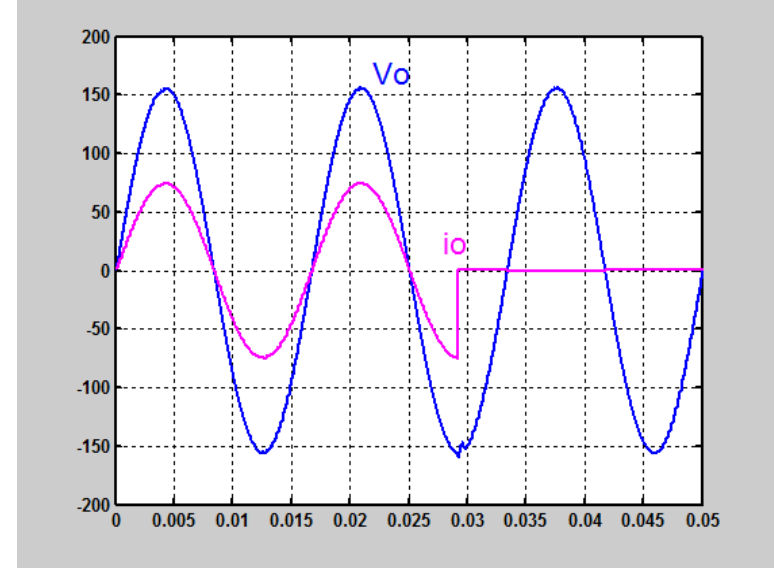
Figure 3. Simulated waveforms under the load suddenly turn off for the classic finite-time convergence control (FTCC) (50 V/div; 10 A/div).